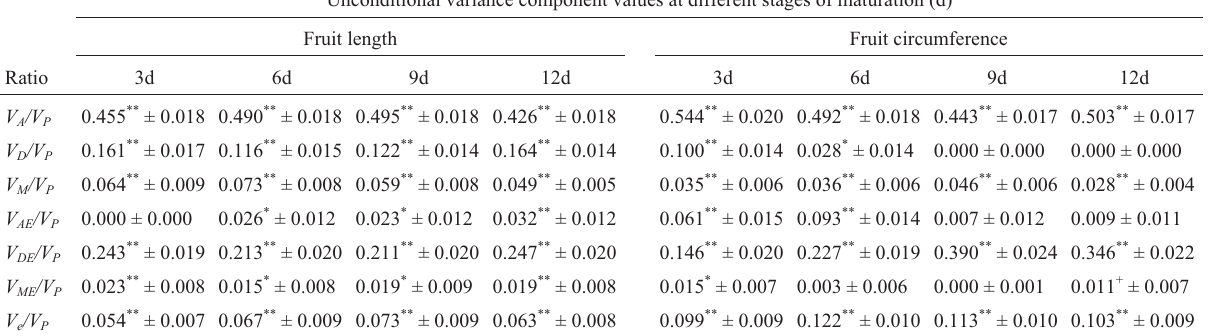
Table 2 - Estimation of unconditional variance components of sponge gourd ( Luffa cylindrical (L) Roem.) fruit length and circumference at different stages of